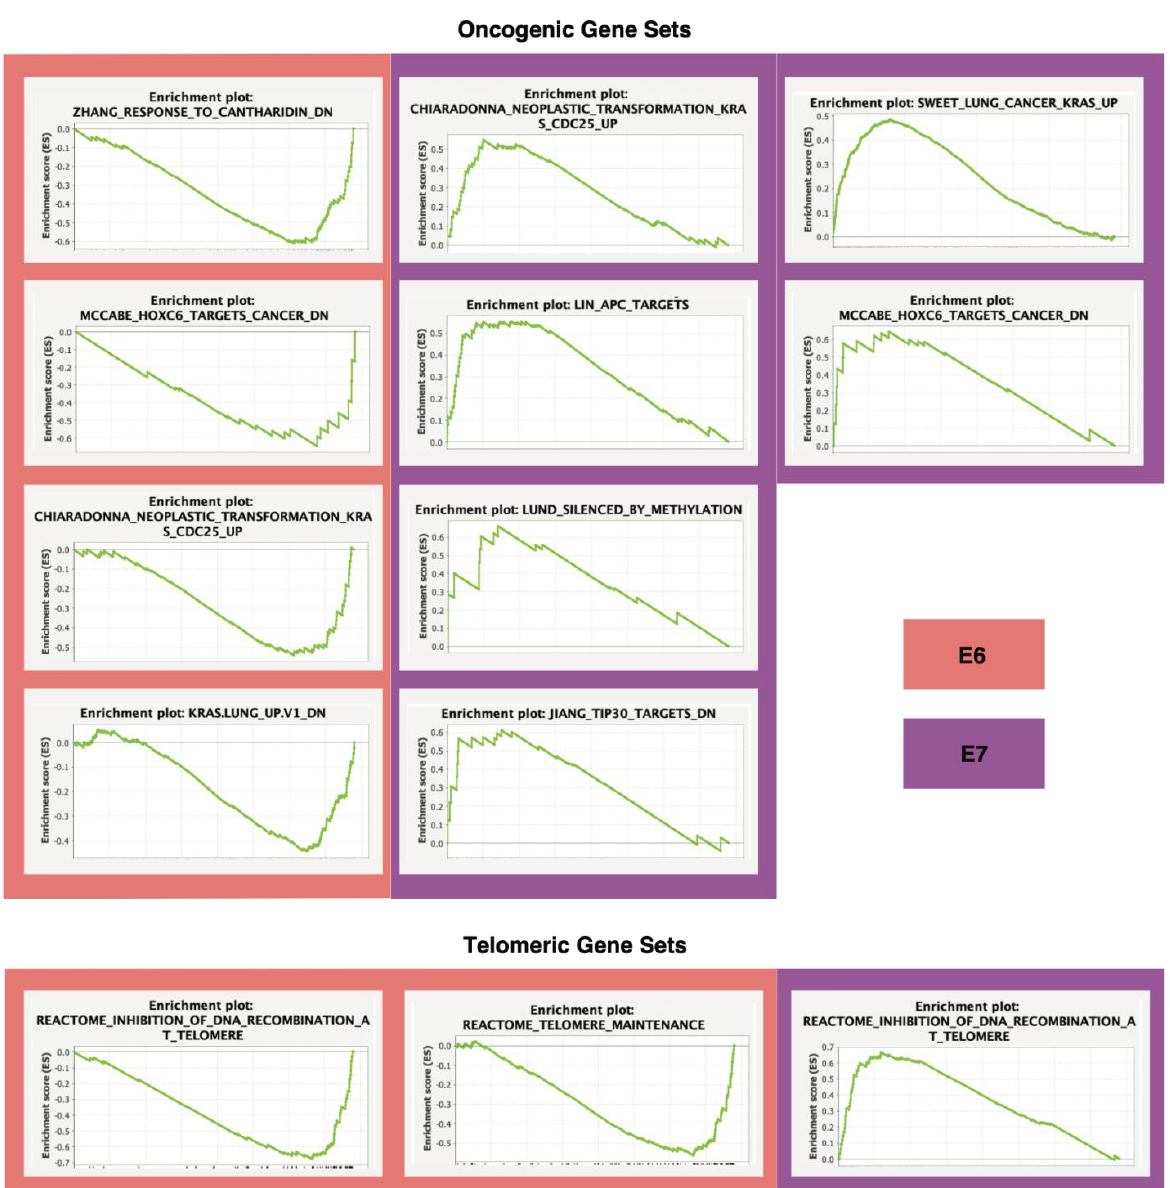
Figure 7. Significant oncogenic and telomeric signaling pathways. Enrichment plots of several significant oncogenic and telomeric gene sets by E6/E7 expression. Enrichment scores (ESs) describe the extent of which gene sets are dysregulated across cohorts. Patients were categorized by individual E6 (pink) and E7 (purple) TPM, with TPM ≥ 10 considered high expression, and TPM < 10 low expression.